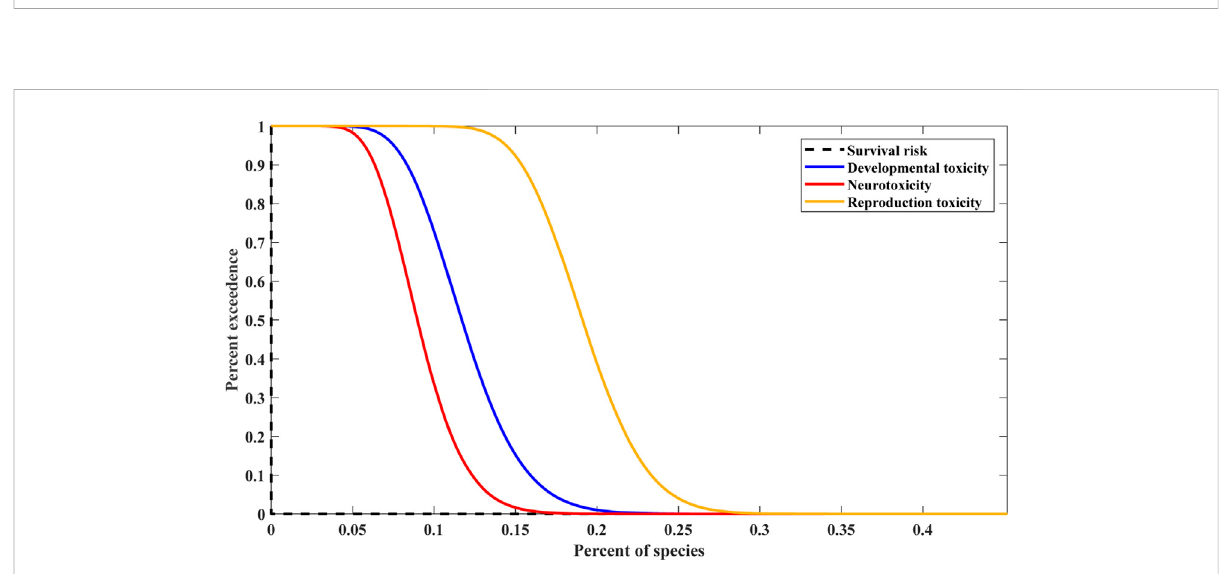
FIGURE 2 Joint probability curves for ecological risk of TCEP in the surface